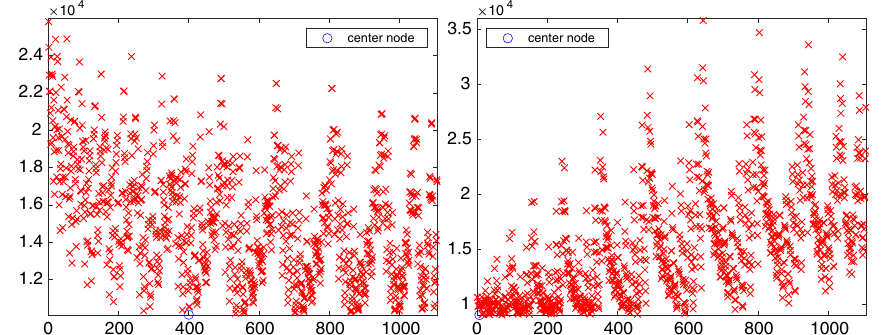
Fig. 14 Network gre (1107 vertices): the chain length and lower bandwidth of the chain-like structure determined by out-trees (left) and in-trees (right) rooted at each vertex